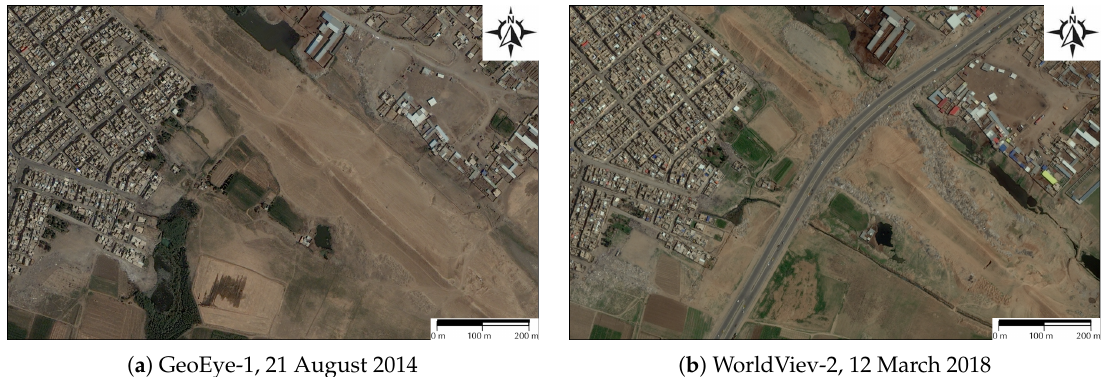
Figure 5. Partial destruction and construction damage types due to large infrastructure, such as highways passing through the area, have damaged ancient walls c (cid:13) DigitalGlobe.